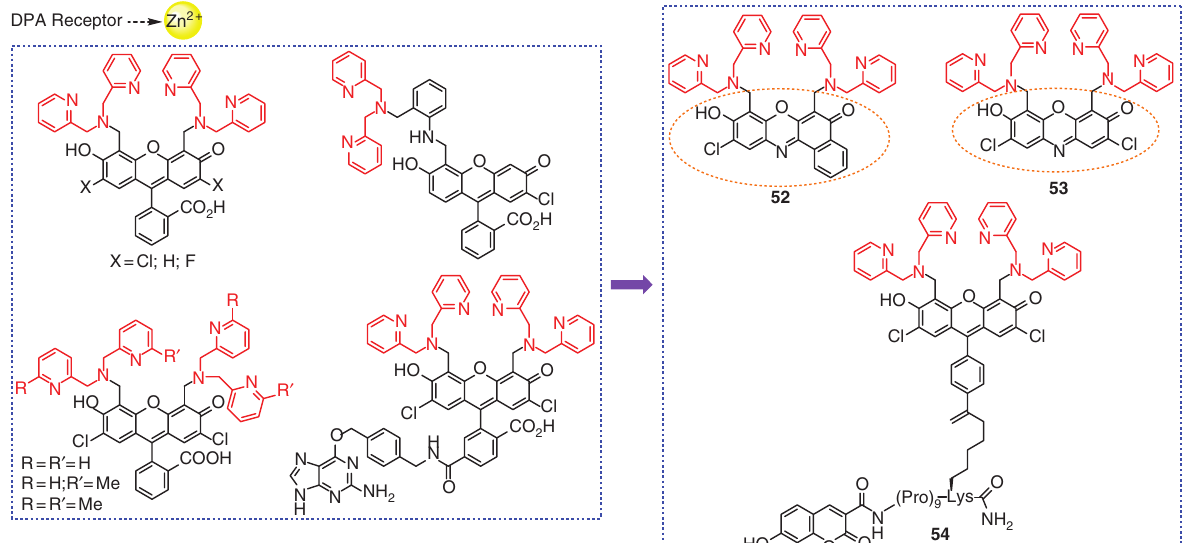
Figure 35: Xanthene fluorescent probes with DPA structure for detecting Zn 2 +